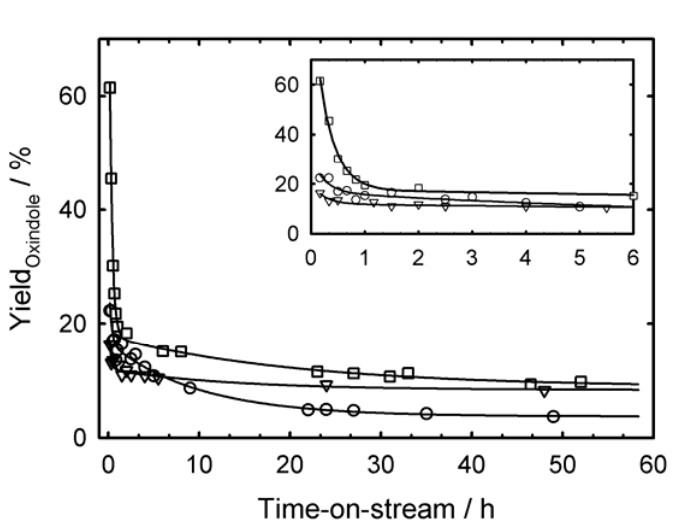
Figure 9. Tandem reaction with 150 U CPO-GA-ATS-SBA-15 and 7 U GOx-GA-ATS- SBA-15 (triangle), 150 U CPO-SBA-15 and 7 U GOx-SBA-15 (circle), 265 U CPO-GA- ATS-SBA-15 and 10.5 U GOx-GA-ATS-SBA-15 (square) as catalysts in the indole oxidation. T = 20 °C; substrate: indole (3.5 mM), glucose (50 mM), flow rate = 0.5 mL min -1 , R average particle size = 2 μ m in (as determined by